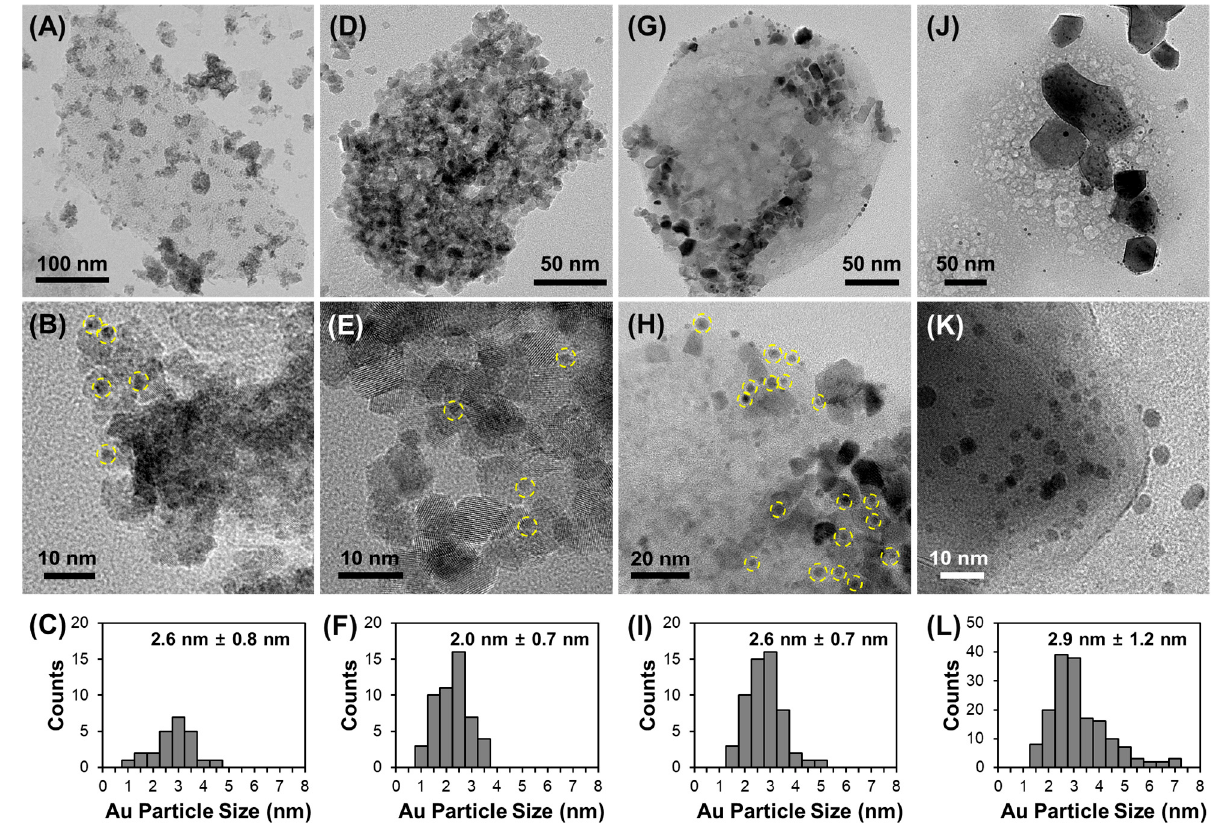
Figure 5. Transmission electron micrograph images and histograms for size distributions of Au nanoparticles of AuCM samples: ( A – C ) AuCM(450), ( D – F ) AuCM(600), ( G – I ) AuCM(750), and ( J – L ) AuCM(1000). Yellow dashed circles indicate Au nanoparticles.